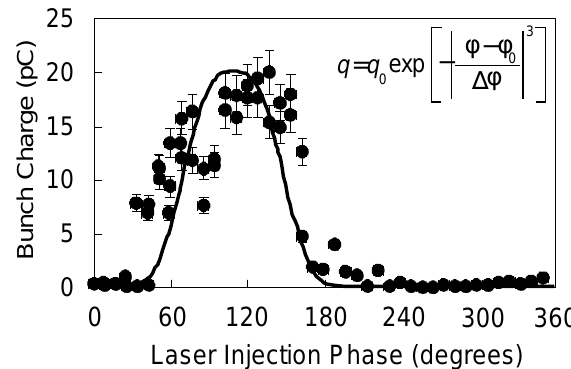
FIG. 13. Measured bunch charge versus rf phase when the laser is injected, showing the Schottky effect. The dots are the actual data, and the line is the fit to the super-Gaussian with equation shown. [This fit is used to match the shape of the data; compare with Fig. 17(b)].